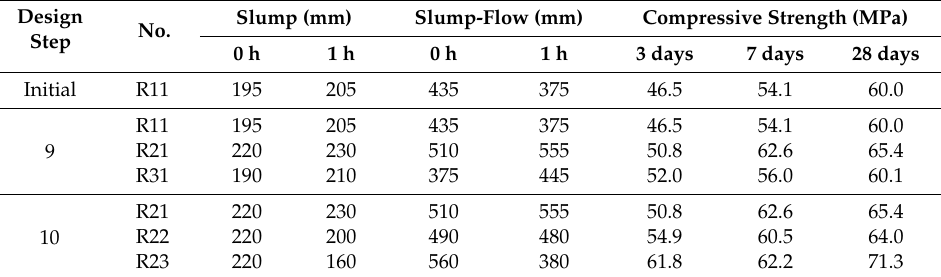
Table 8. The performance of the concrete samples.